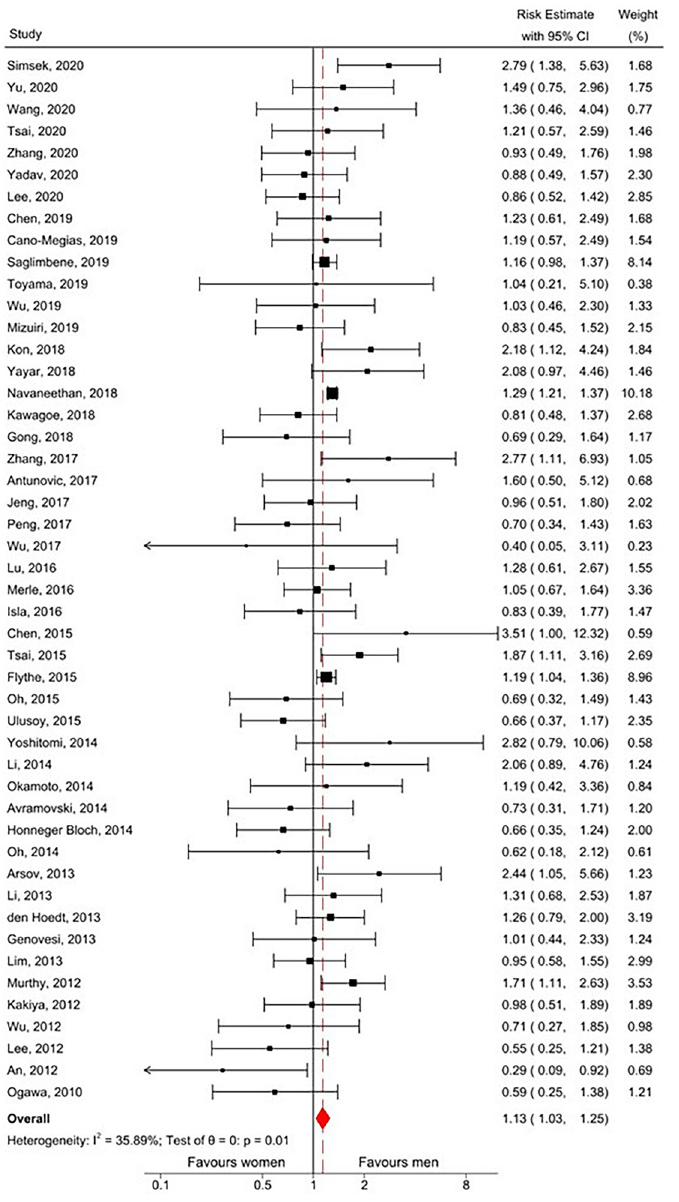
Fig 4. Forest plot of meta-analysis of risk estimates of all included studies. CI, confidence interval. I 2 , Measure of heterogeneity. θ , Risk estimate. p, p-value.